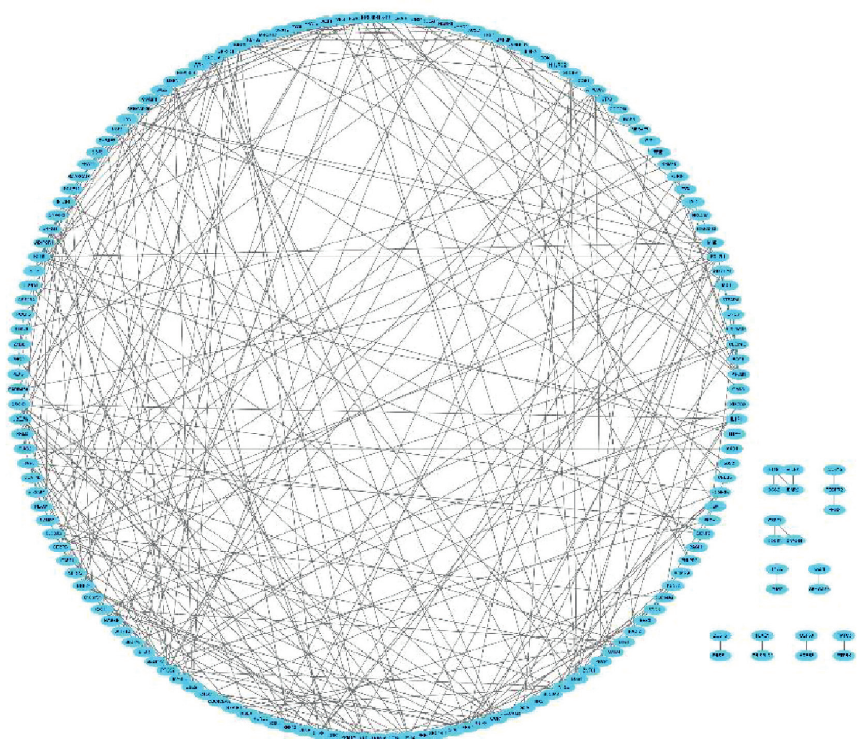
Figure 4: The PPI network based on the 267 target DEmRNAs in coronary artery disease. This network contained 173 nodes and 277 edges. PPI, protein-protein interaction; DEmRNAs, differentially expressed